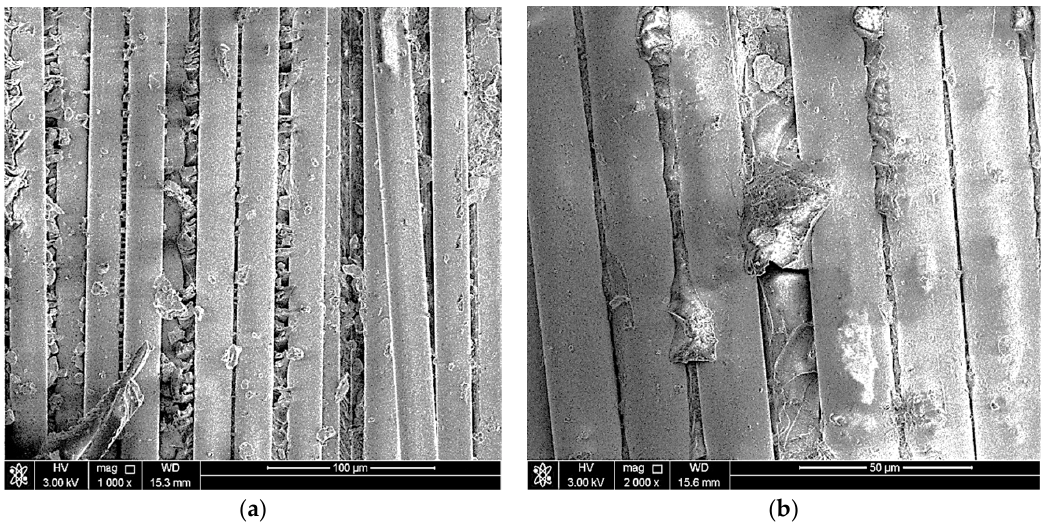
Figure 6. SEM images of the fractured region at ( a ) 1000× and ( b ) 2000×.